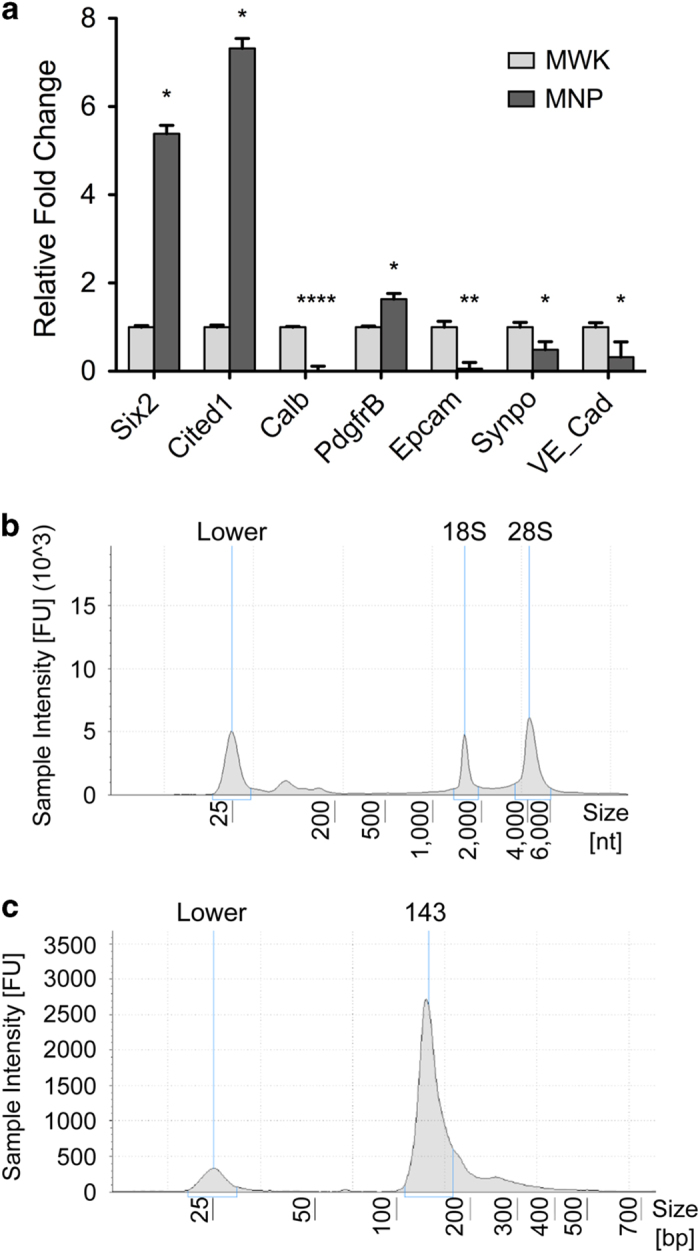
Quality control of the input samples demonstrated an enrichment of nephron progenitors in the cellular isolate with good quality RNA, and successful cDNA library synthesis.(a) qPCR analysis showed that the cells in the isolate are enriched for nephron progenitors (Six2, Cited1) with minimal cellular contamination from ureteric bud (Calb), podocytes (Synpo), endothelial (VE-Cad) and epithelial cells (Epcam), but minor contamination from the renal stroma lineage (Pdgfrβ). (b) TapeStation analysis of the total RNA showed good quality RNA traces with distinct 18S and 28S rRNA peaks with retention of small RNAs as evident by the broad peak to the right of the lower molecular marker. (c) TapeStation analysis showed that the purified cDNA libraries exhibited a distinct peak at ~140–150 nucleotides (adaptor ligated small RNA products), indicating that both the cDNA library construction and cleanup are successful. N=3, ∗p-value<0.05, ∗∗p-value<0.01, ∗∗∗∗p-value<0.0001.